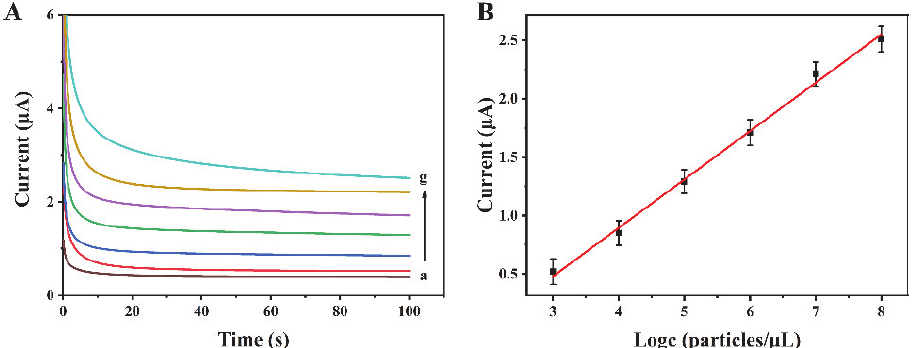
Figure 4. ( A ) Current curves for different concentrations of exosomes. a–g are 0, 10 3 , 10 4 , 10 5 , 10 6 , 10 7 , and 10 8 particles/ μ L, respectively. ( B ) The linear relationship between the current intensity and the logarithm of exosome concentration. Table 1. Comparison of the developed method with some other reports.